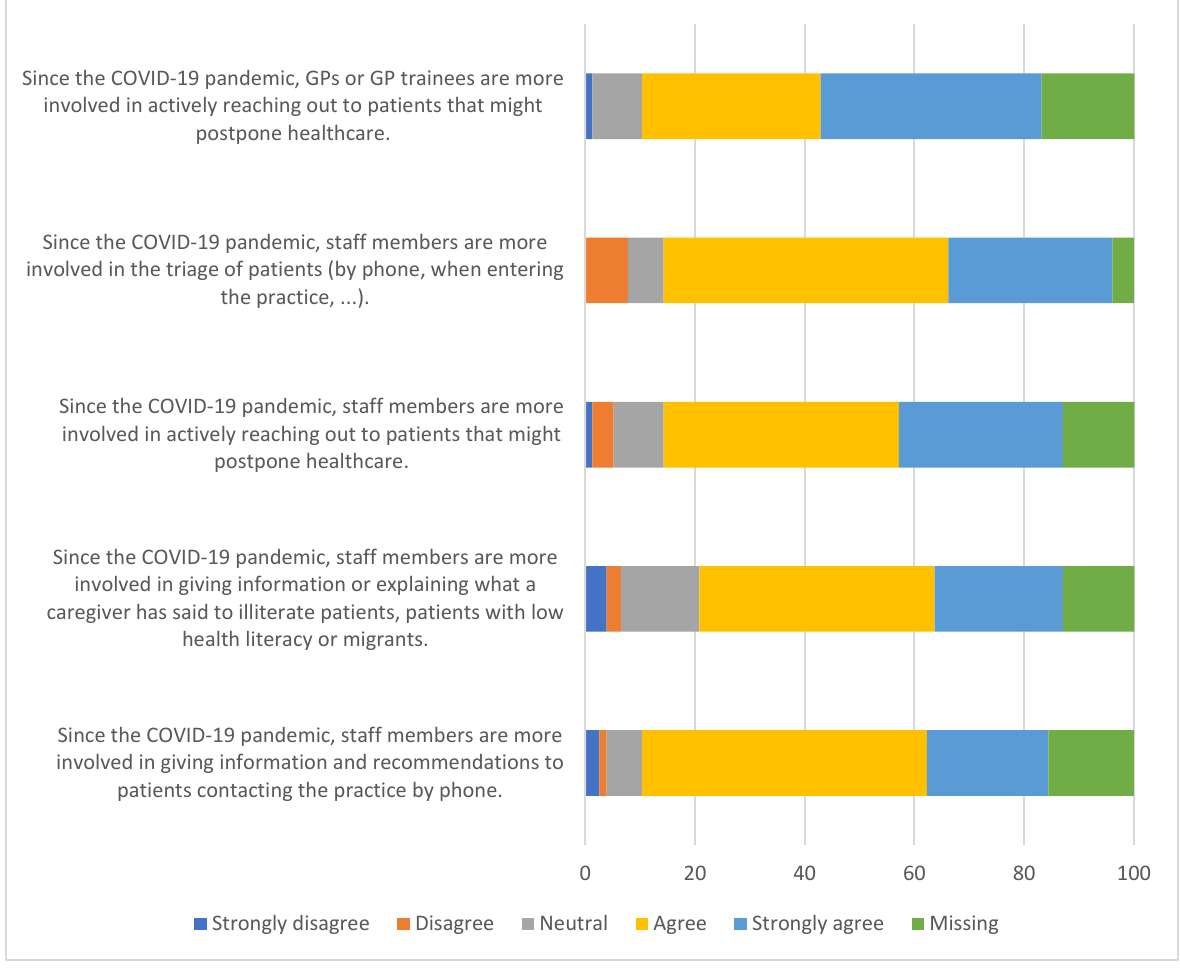
Figure 3. Support services at the Primary Healthcare Practices to improve patient health since the COVID-19 pandemic. GP = general practitioner.